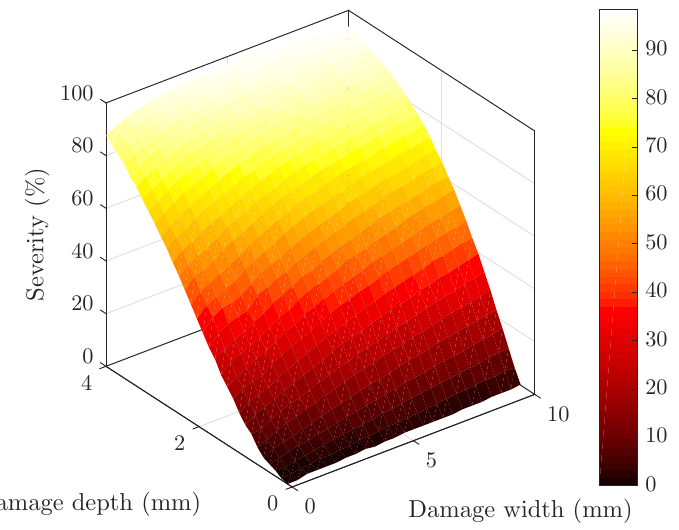
Figure 5. Surface view of the damage library built at midposition (0.5 m) of a cantilever